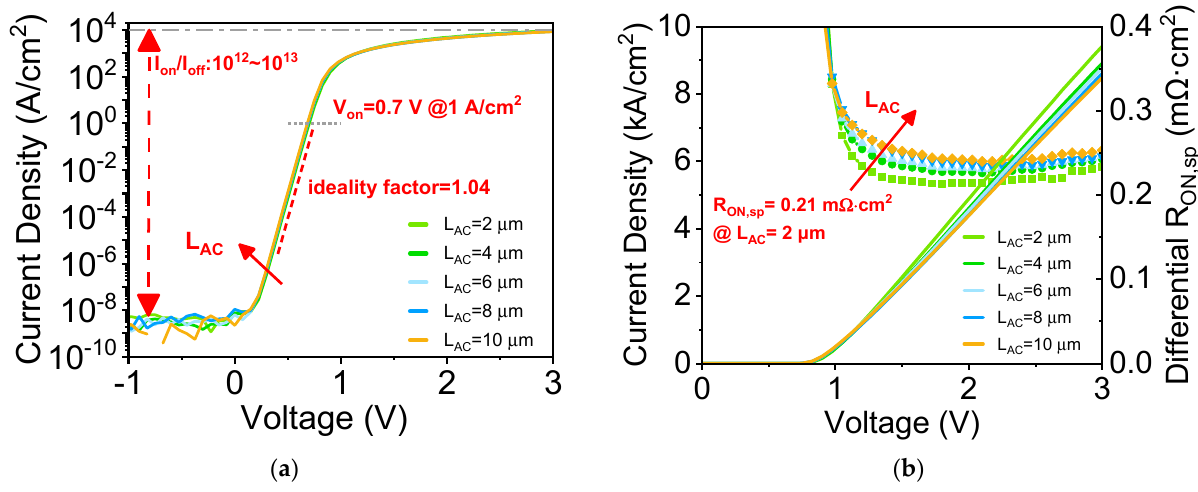
Figure 3. ( a ) Forward I-V characteristics in semi-log scale, and ( b ) in linear scale (left) and differential R ON,sp vs. voltage (right) for vertical GaN SBDs with different spacing between the anode and cathode (L AC = 2, 4, 6, 8, 10 μ m).